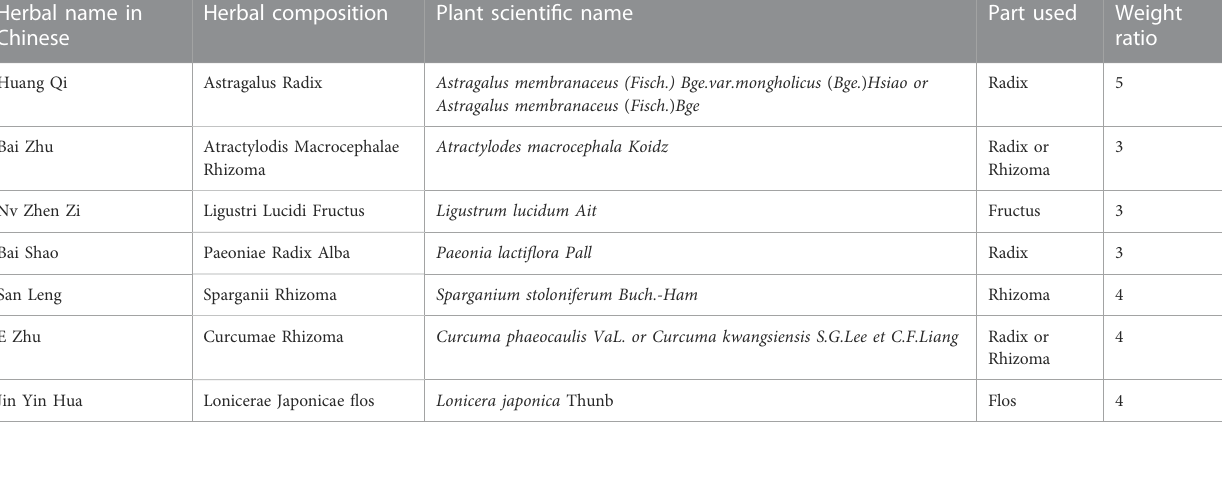
TABLE 2 Molecular mechanisms responsible for the pharmacologic activity of SHT. Model class